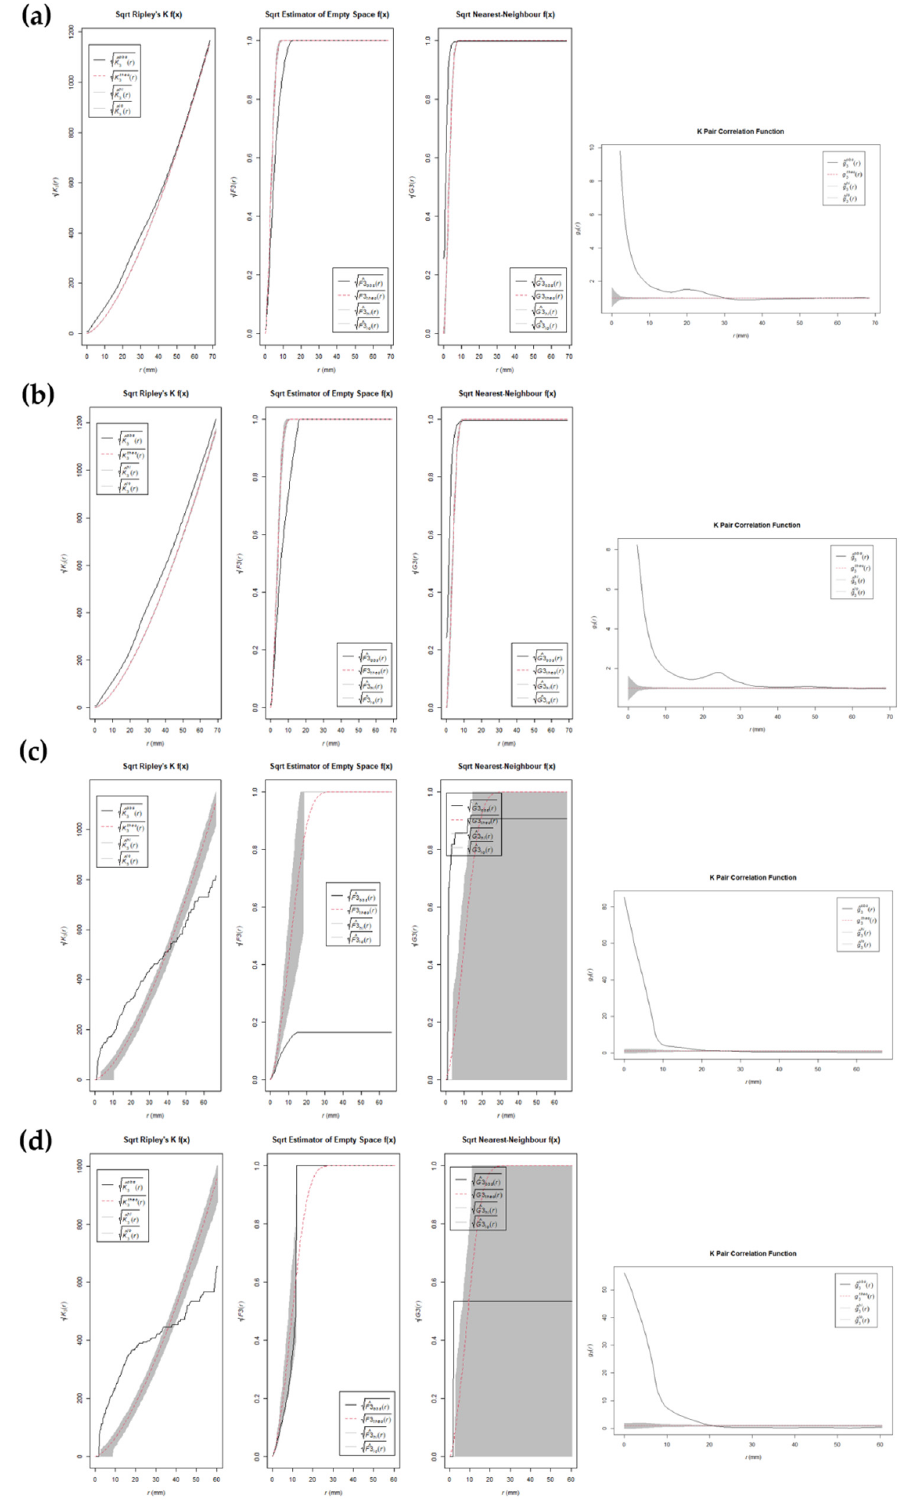
Figure 5. Plots of the square root version of the K-function, F empty space function, G near-neighbor function, and pair-correlation function for ( a ) tooth marks on right tibiae generated by captive wolves; ( b ) tooth marks on left tibiae generated by captive wolves; ( c ) tooth marks on right tibiae generated by wild wolves; ( d ) tooth marks on left tibiae generated by wild wolves. Dotted red line shows the Poisson complete spatial random (CSR) process, the black line shows the empirical point process of the target sample, and the gray band shows simulated confidence